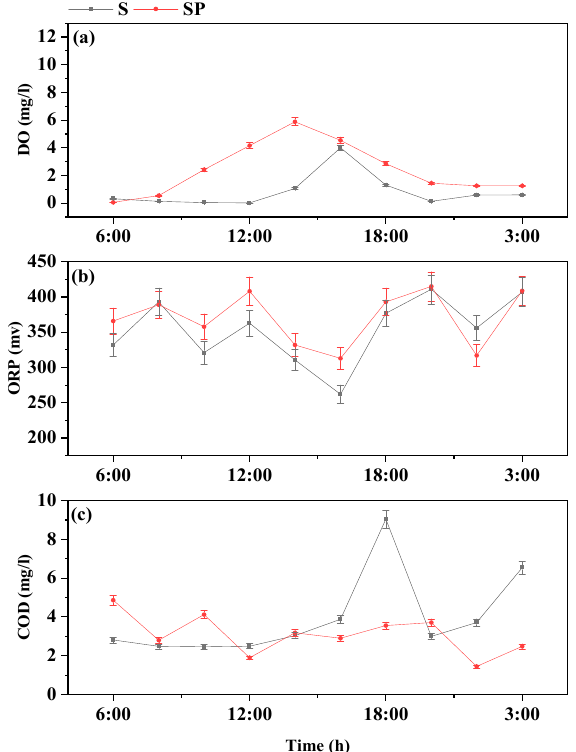
Figure 4. Diurnal variation of the water DO, ORP and COD in the agricultural drainage ditch. ( a ) dissolved oxygen content in water; ( b ) water ORP; ( c ) COD in water.